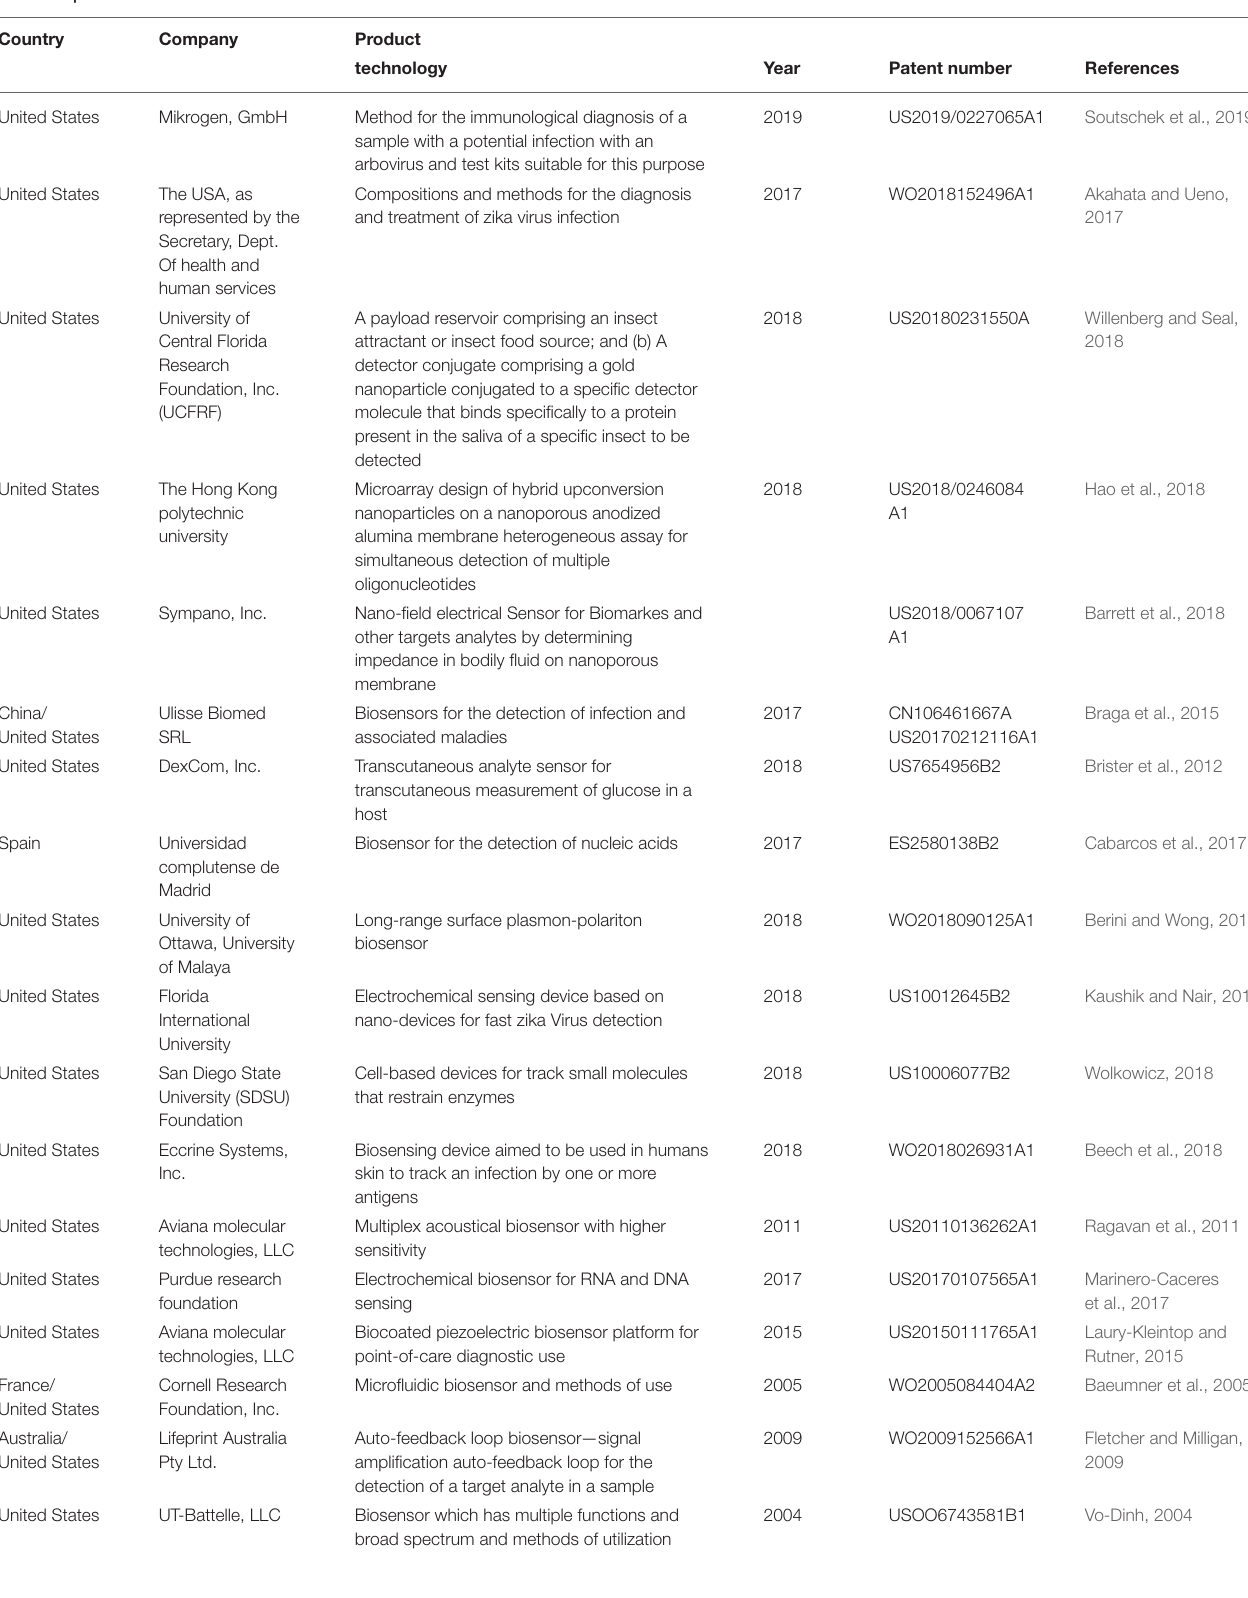
TABLE 2 | Patents related to the detection and control of